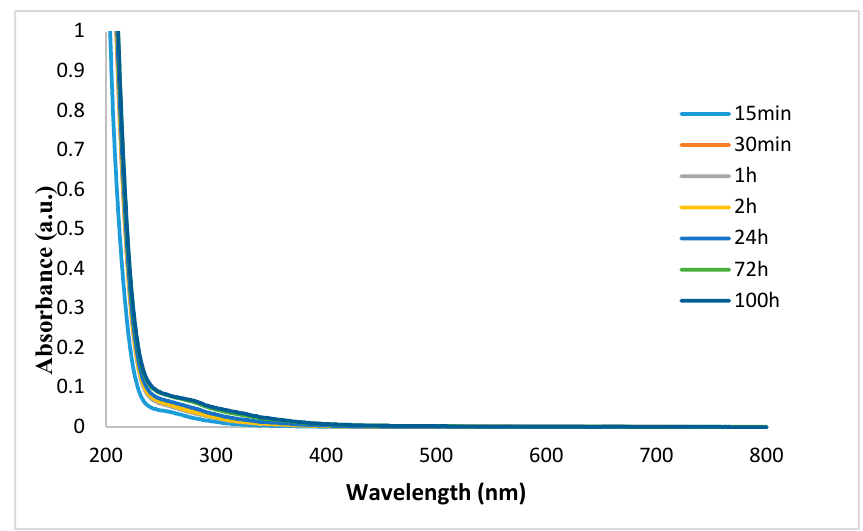
Figure 12. UV-Vis spectra of Ag/ZnO-treated flax washing solutions evaluated at different time points.